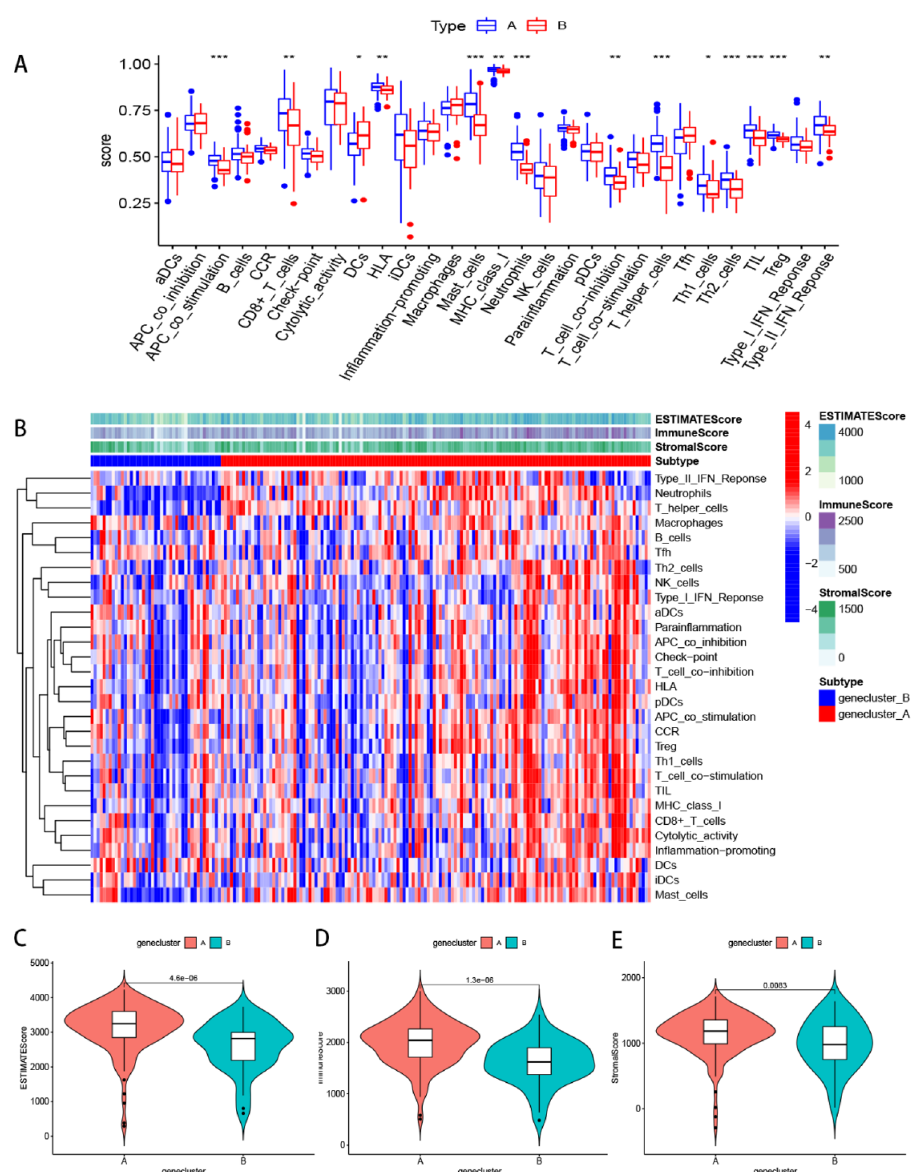
Figure 11. Single sample gene set enrichment analysis of the two gene clusters. ( A ) The boxplot of immune function in the two gene patterns. * p < 0.05, ** p < 0.01, and *** p < 0.001. ( B ) The heatmap of immune function in the two gene patterns. Other characteristics including estimate score, immune score, and stromal score. Differential estimate score ( C ), immune score ( D ), and stromal score ( E ) between m5Ccluster A and